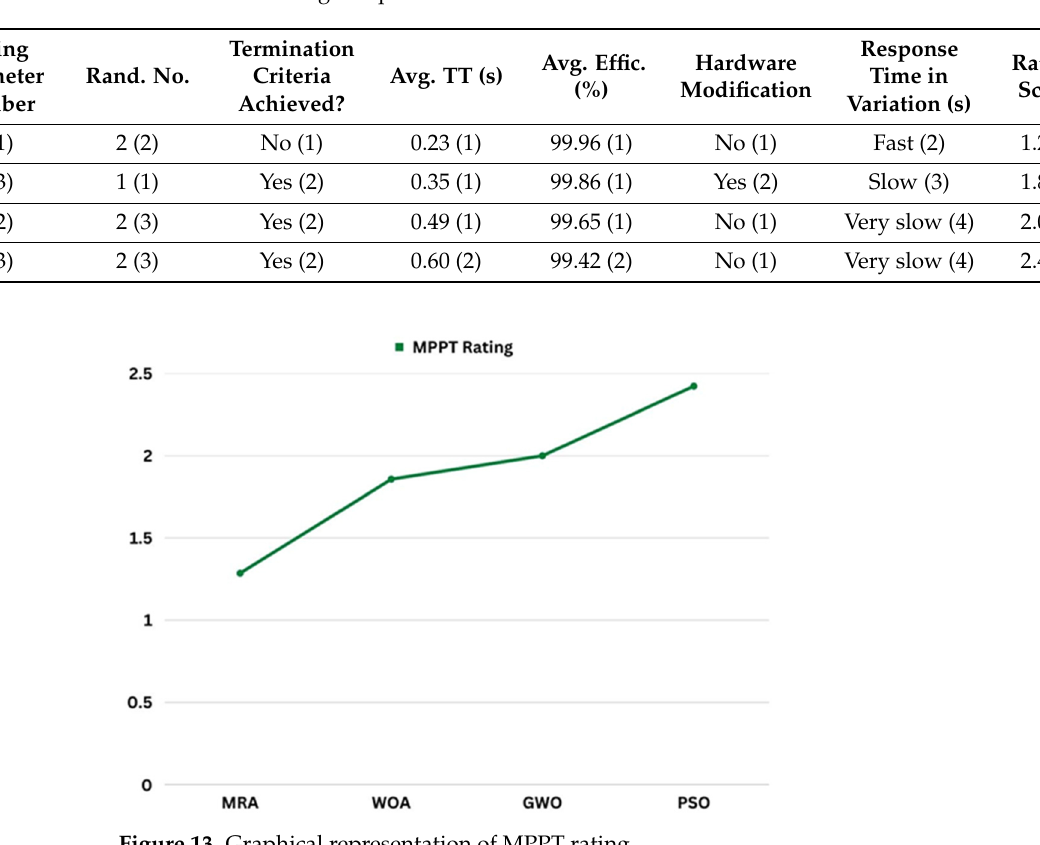
Table 3. MPPT rating comparison.